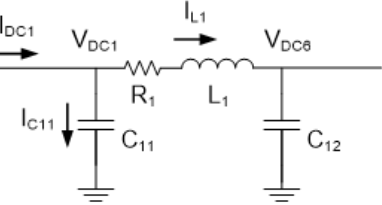
Figure 11. Equivalent circuit for the developed state-space model of a dc nanogrid.